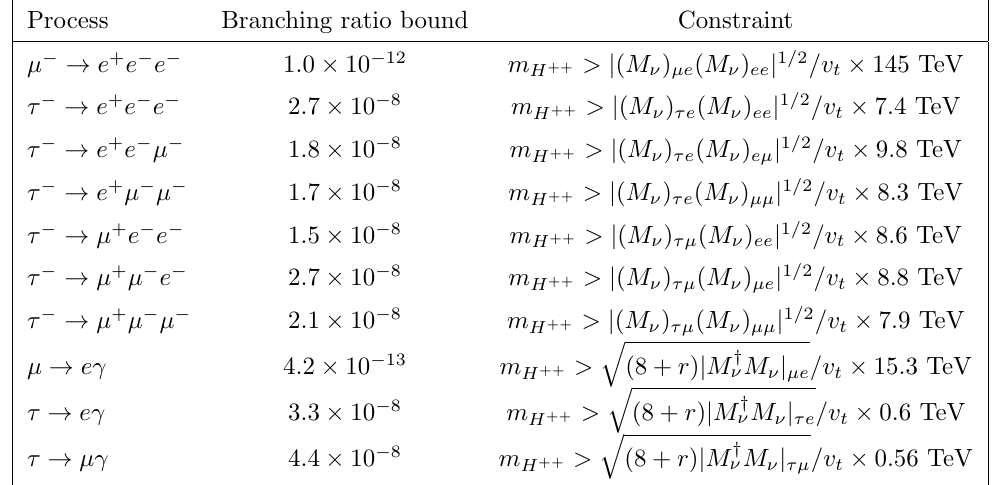
p 2 fv t to express =m 2 . H ++ H +